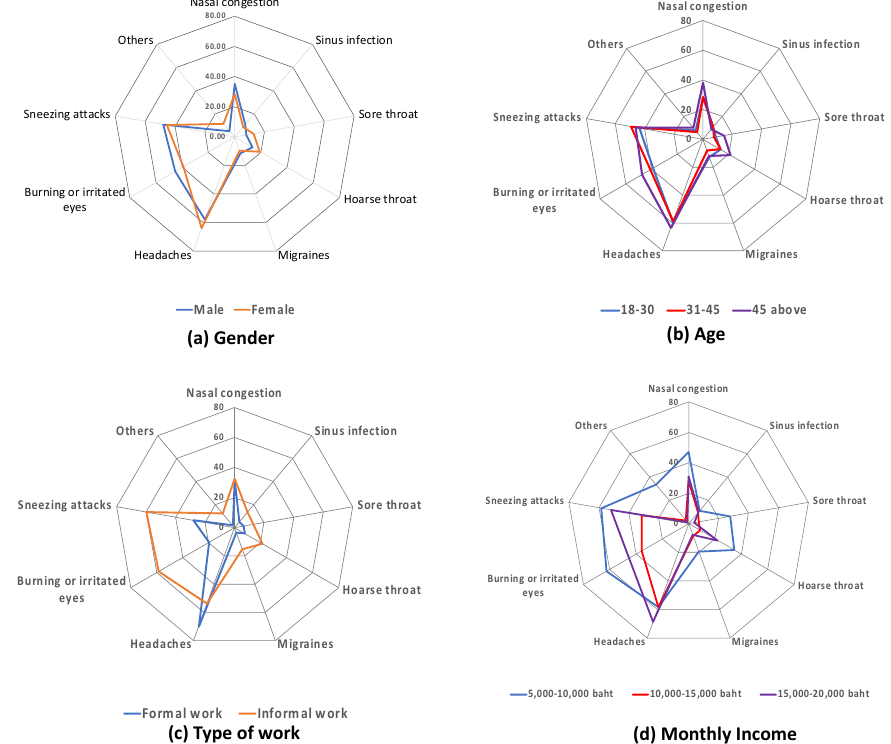
Figure 6. Health symptoms of different socio-economic groups.